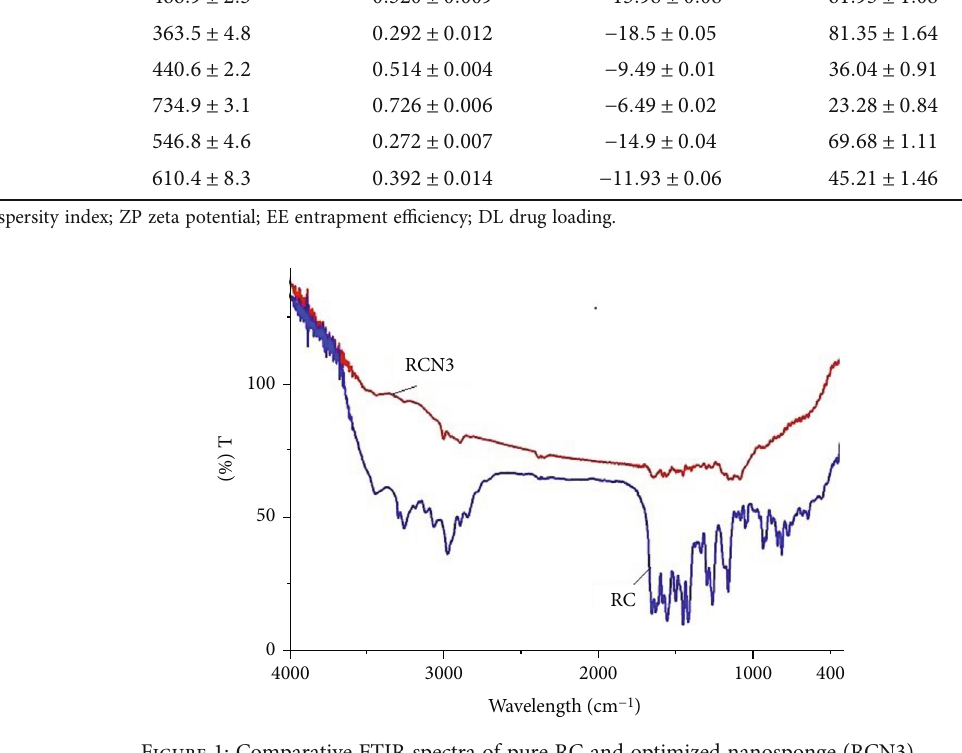
Figure 1: Comparative FTIR spectra of pure RC and optimized nanosponge (RCN3).